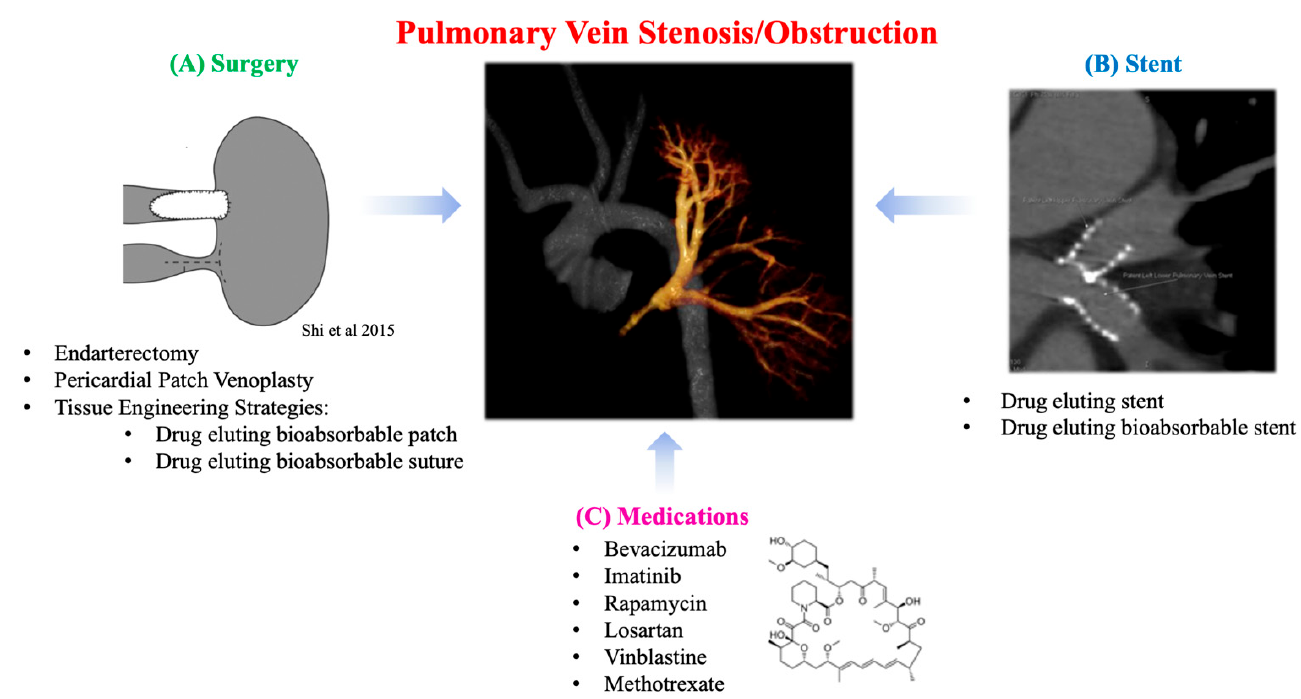
Figure 3. Treatment modalities for pulmonary vein stenosis/obstruction. The middle image is a clinical CT reconstruction from a pediatric patient who had pulmonary vein obstruction. ( A ) Describes surgical treatment options for pulmonary vein stenosis/obstruction and lists two potential tissue-engineering strategies for surgical management. Image is from Shi et al. 2015 [83] . ( B ) Clinical CT image from the patient who underwent stent placements for treatment of pulmonary vein obstruction. ( C ) Medications that have been studied to help in the treatment of pulmonary vein stenosis/obstruction. In 2018, the ethics committee at Nationwide Children’s Hospital approved the percutaneous intervention of pulmonary vein obstruction in human subjects. Informed consent was obtained from each patient, or from the parent/guardian if the patient was a minor, before proceeding.